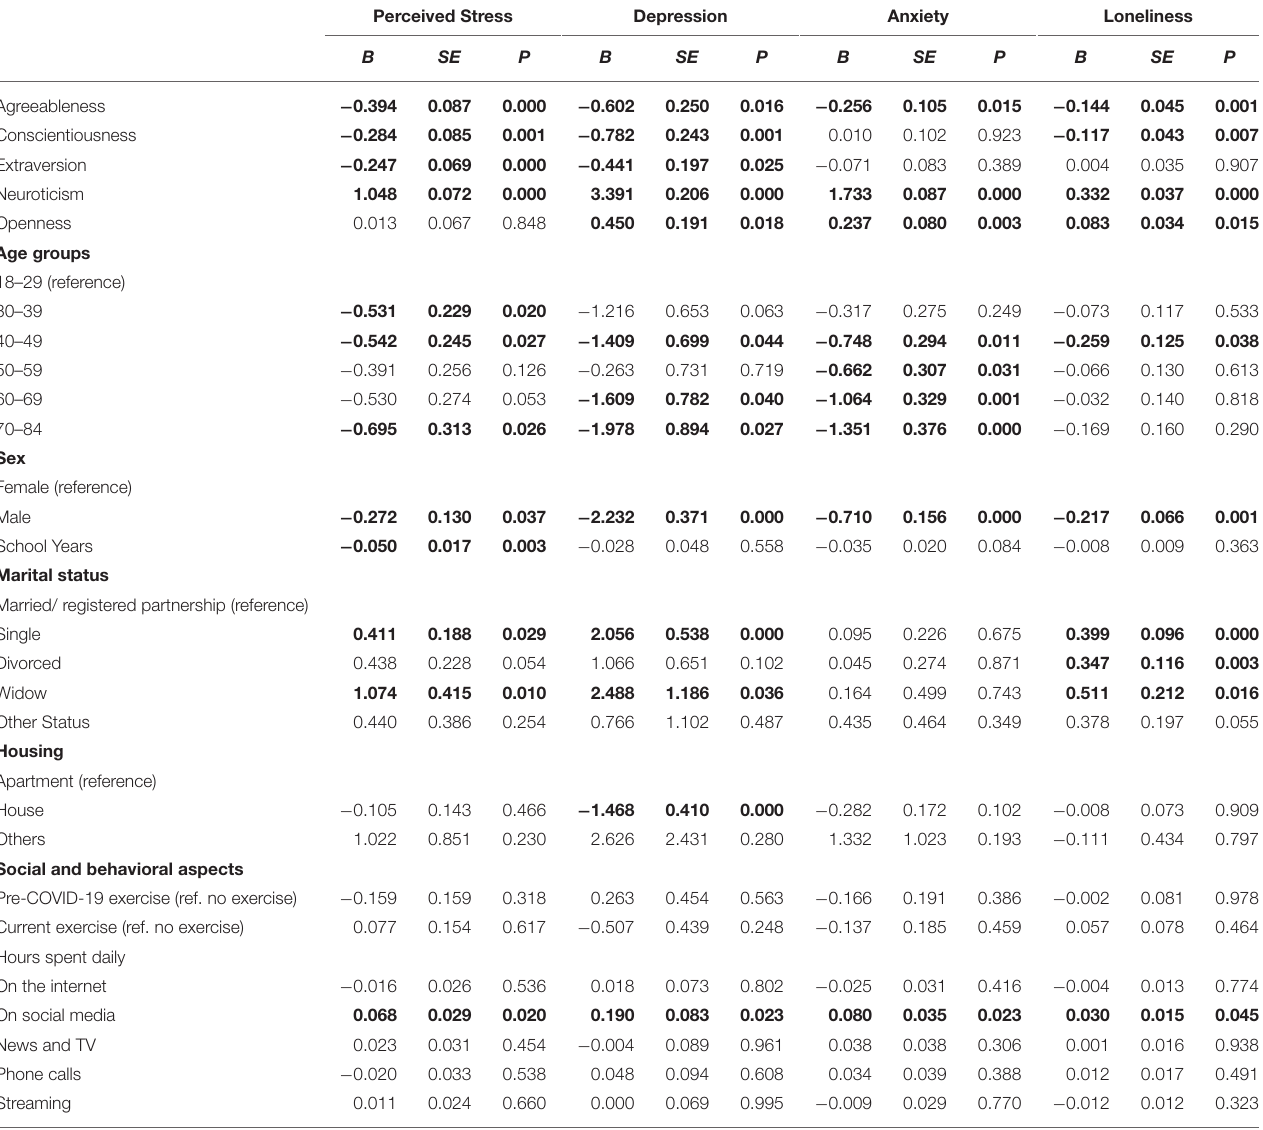
TABLE 3 | Associations of personality traits, mental health outcomes and social and behavioral aspects, controlling for sociodemographic variables. Perceived Stress Depression Anxiety